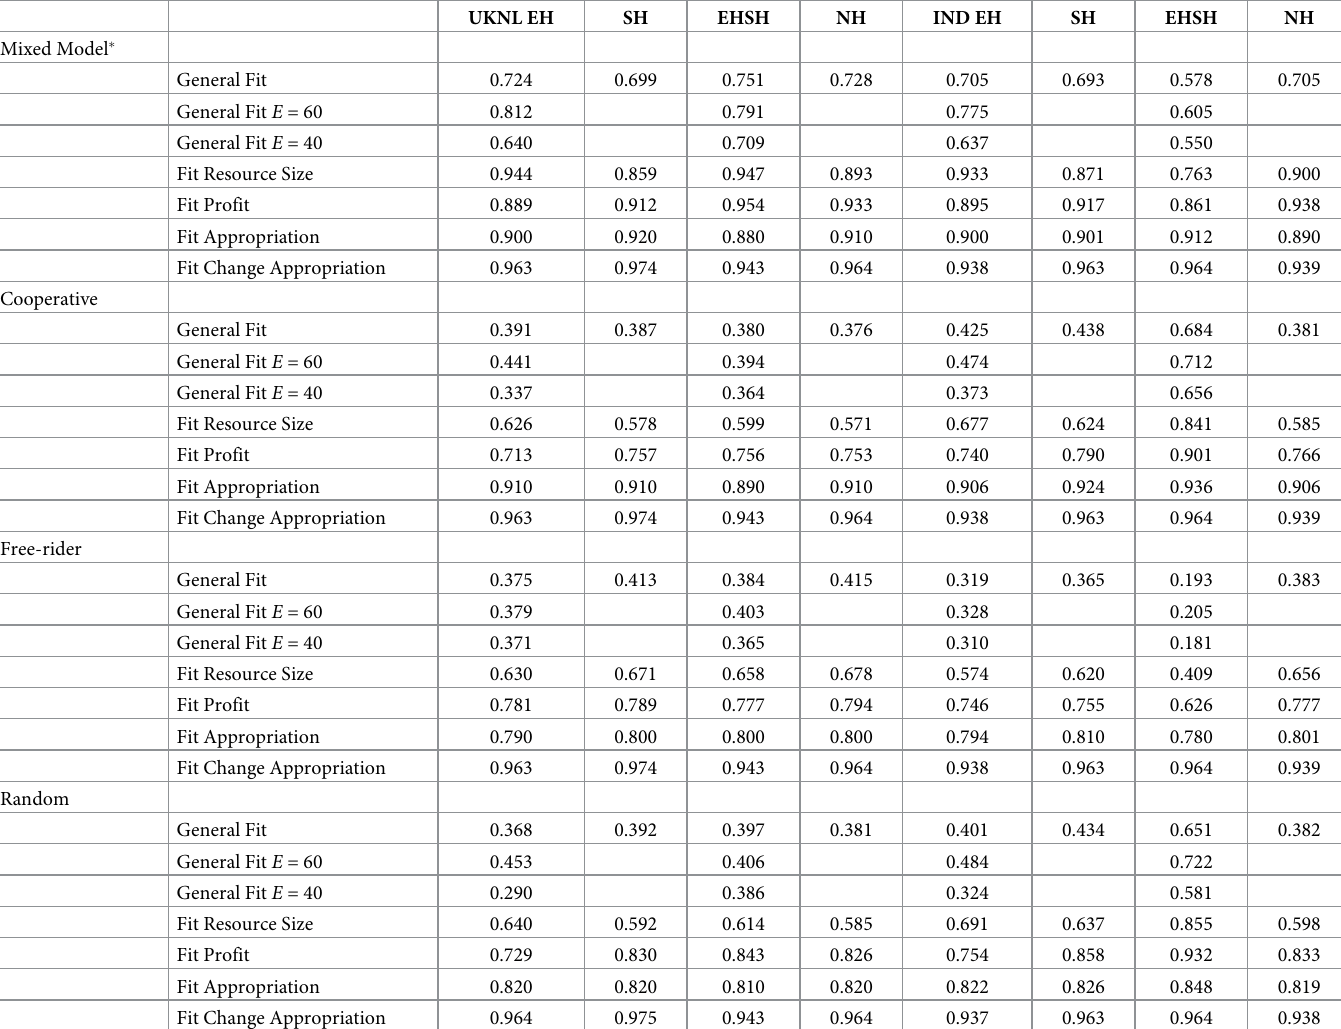
Table 3. Fit score f per ABM per